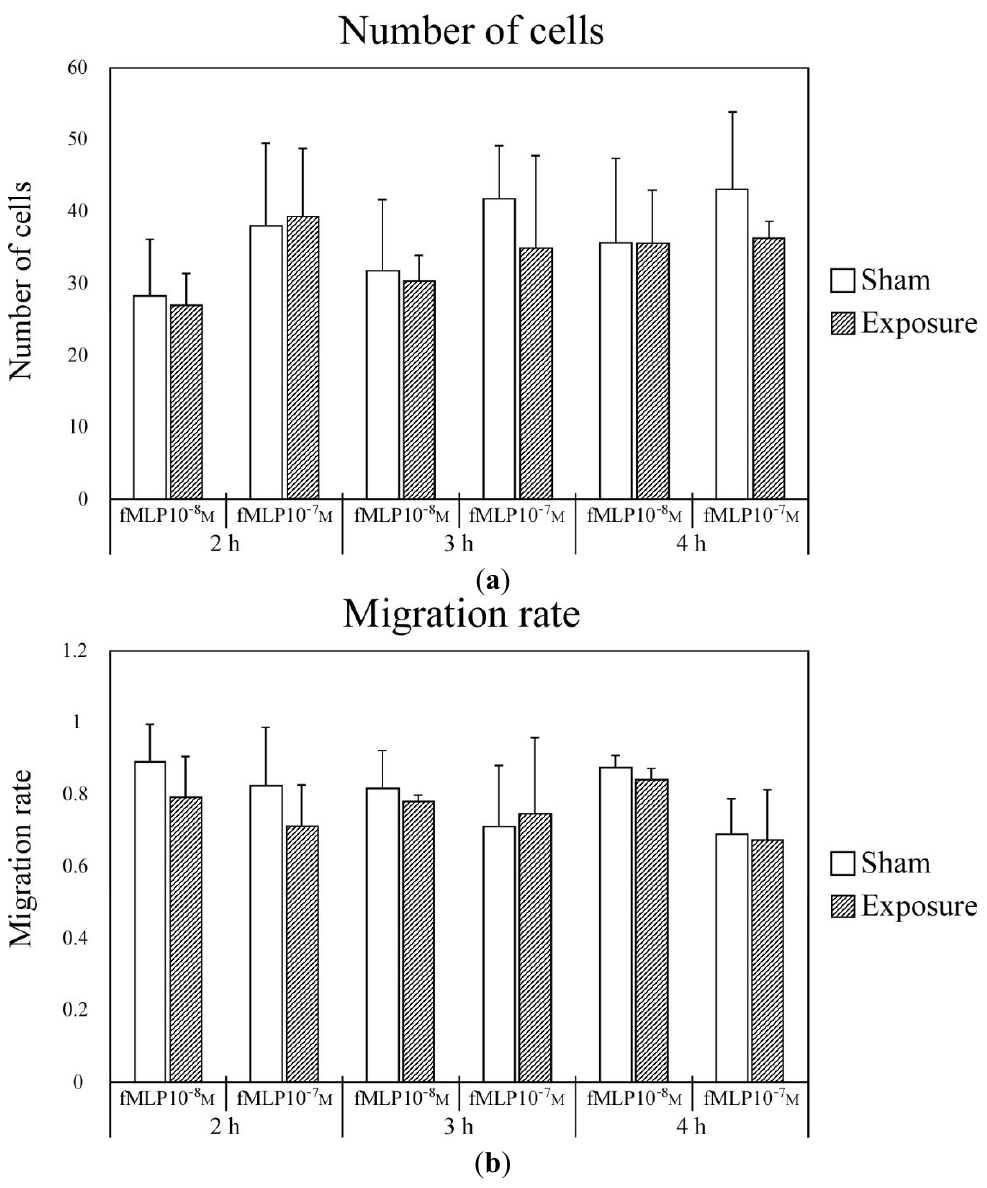
Figure 3. Chemotaxis of differentiated HL-60 cells was assayed using 10 or 100 nM fMLP as the chemoattractant after sham or IF magnetic field exposure for 2, 3, or 4 h. ( a ) Number of differentiated HL-60 cells migrating toward 10 or 100 nM fMLP as the chemoattractant. ( b ) Rate of migration of differentiated HL-60 cells toward 10 or 100 nM fMLP as the